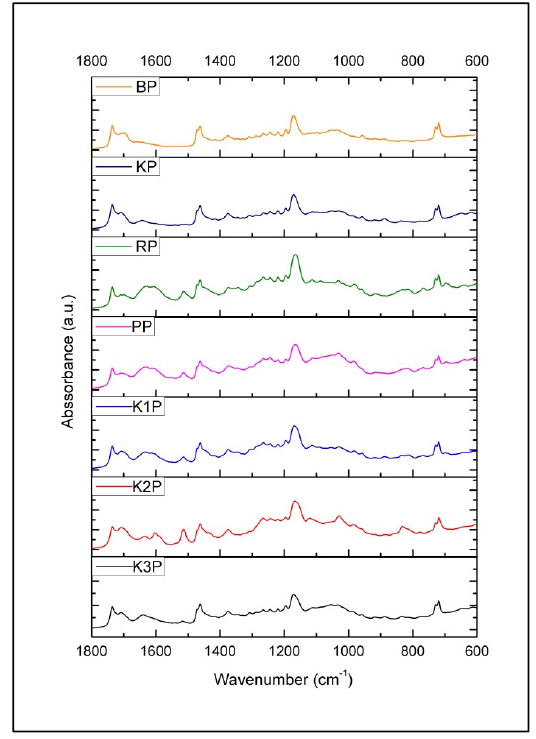
Figure 3. Average FTIR ATR spectrum of investigated propolis collected from five Adriatic Sea islands (Krk, Rab, Pag, Biševo and Kor č ula)—fingerprint region (1800–600 cm − 1 ) emphasizing the most significant spectral variations.